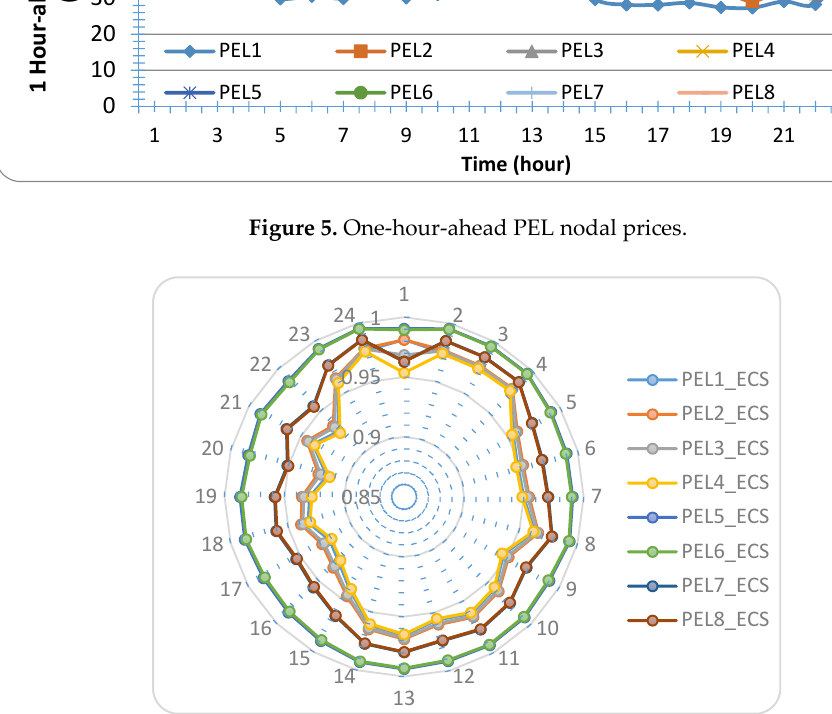
Figure 6. Electricity consumption satisfaction (ECS) of